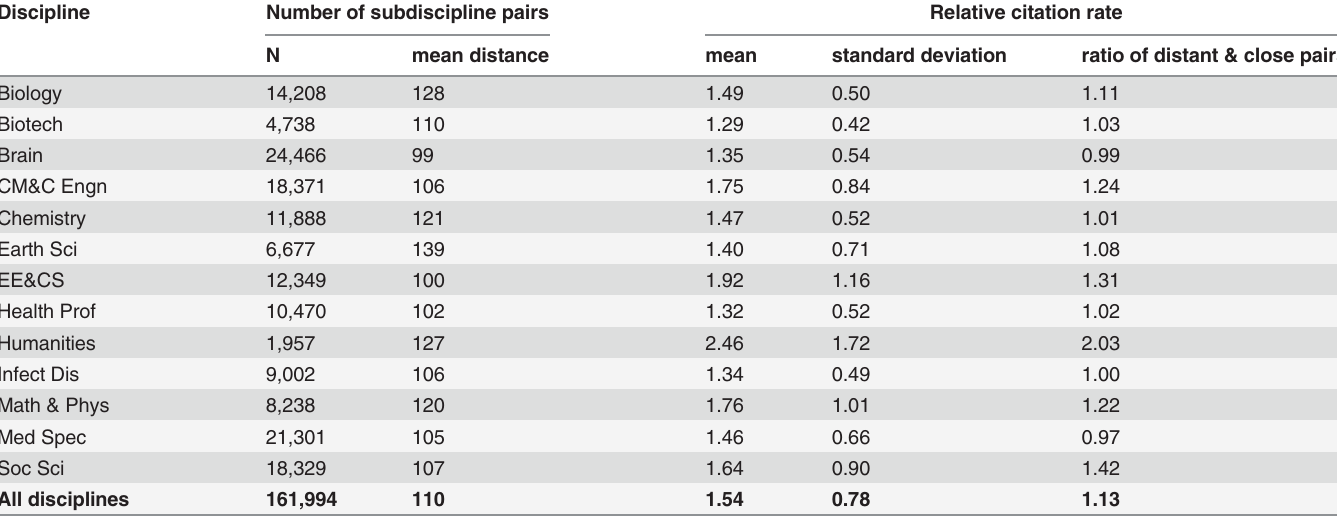
Table 1. Number of interdisciplinary pairs per discipline, mean distance and mean, standard deviation and ratio of distant (F-J) and close (A-E) subdiscipline pairs of relative citation rate.